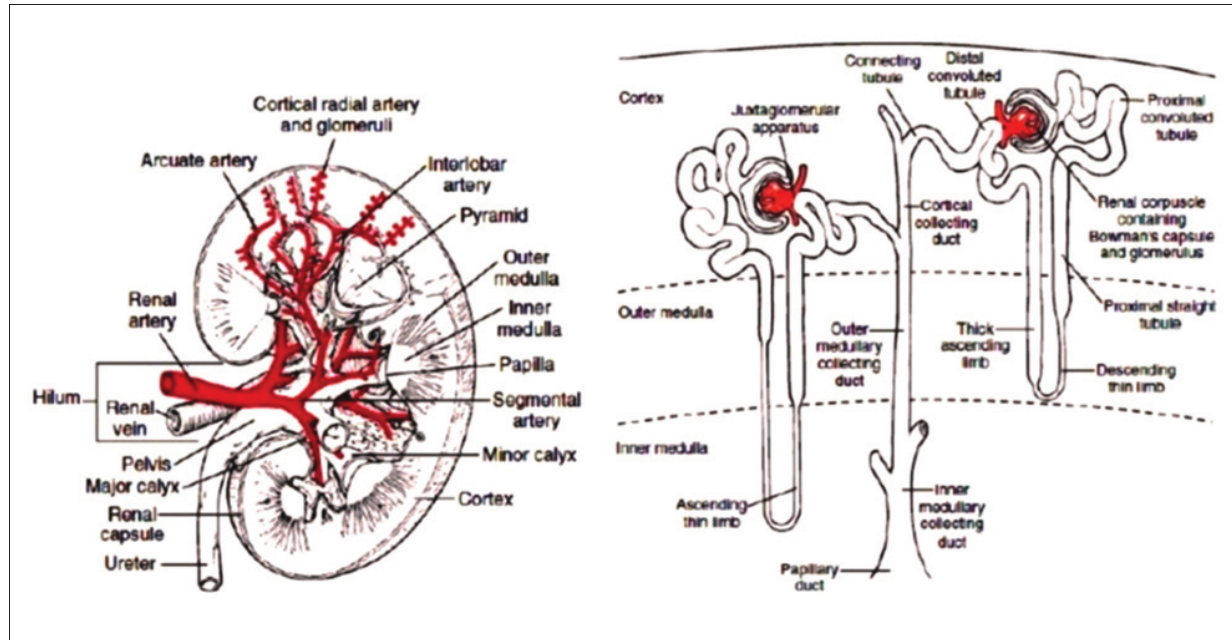
Figure-1: Kidney general structure. (a) The general structure of the kidney, (b) components of the nephron and ductus collectivus system